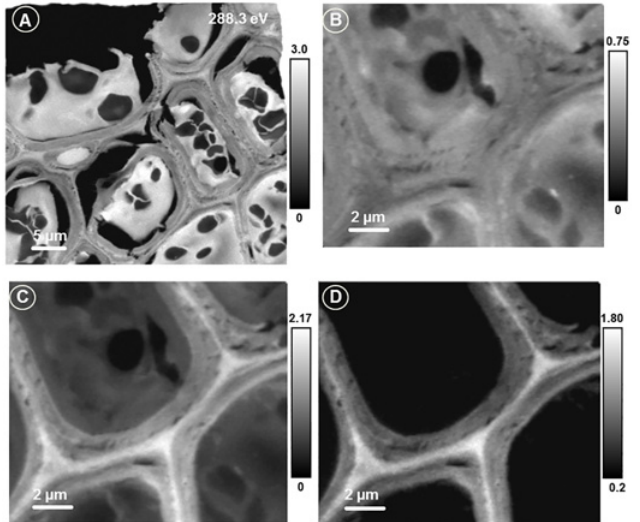
285.7 eV), and lignin distribution (D: C-B) images of lentil stem section. Scale bars indicate X-ray optical density.